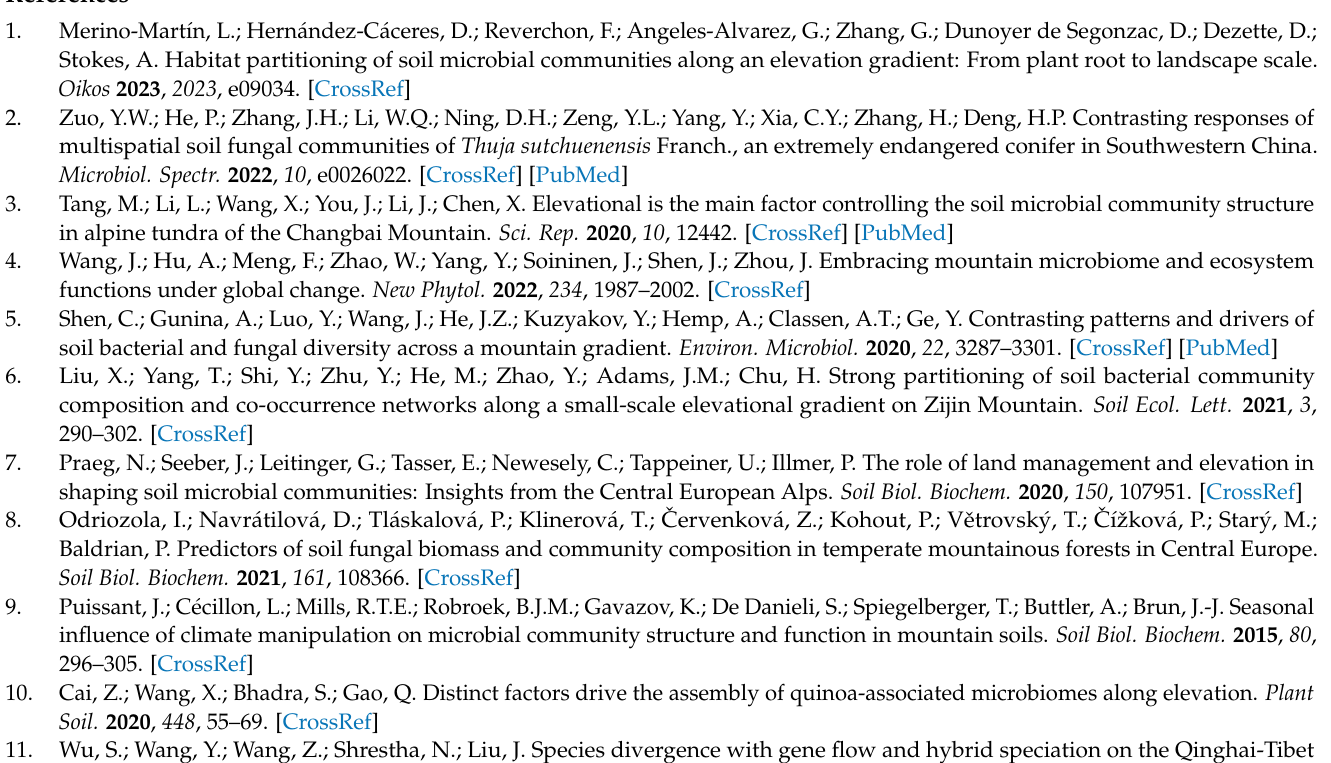
sites; Figure S3: morphological features of pine needles at different elevations; Figure S4: raincloud plot showing needle morphological features at different elevations; Figure S5: rarefaction curves for different groups of samples; Figure S6: composition and relative abundance of microbial communities at the phylum and genus levels; Figure S7: the distribution of samples at different elevations on the PC1 axis analysed by PCoA; Figure S8: variation in OTU abundance with altitudinal gradient; Figure S9: the different groups between the two types of pines at the OTU level and functions of bacteria at the KEGG 2 level; Figure S10: the different groups between rhizosphere soil and roots at the OTU level and functions of bacteria at the KEGG 2 level; Figure S11: RDA/CCA of the microbial communities of different pine types; Figure S12: RDA/CCA of the microbial communities of rhizosphere soil and roots; Table S1: sampling site information; Table S2: Plant information for sampling sites at different